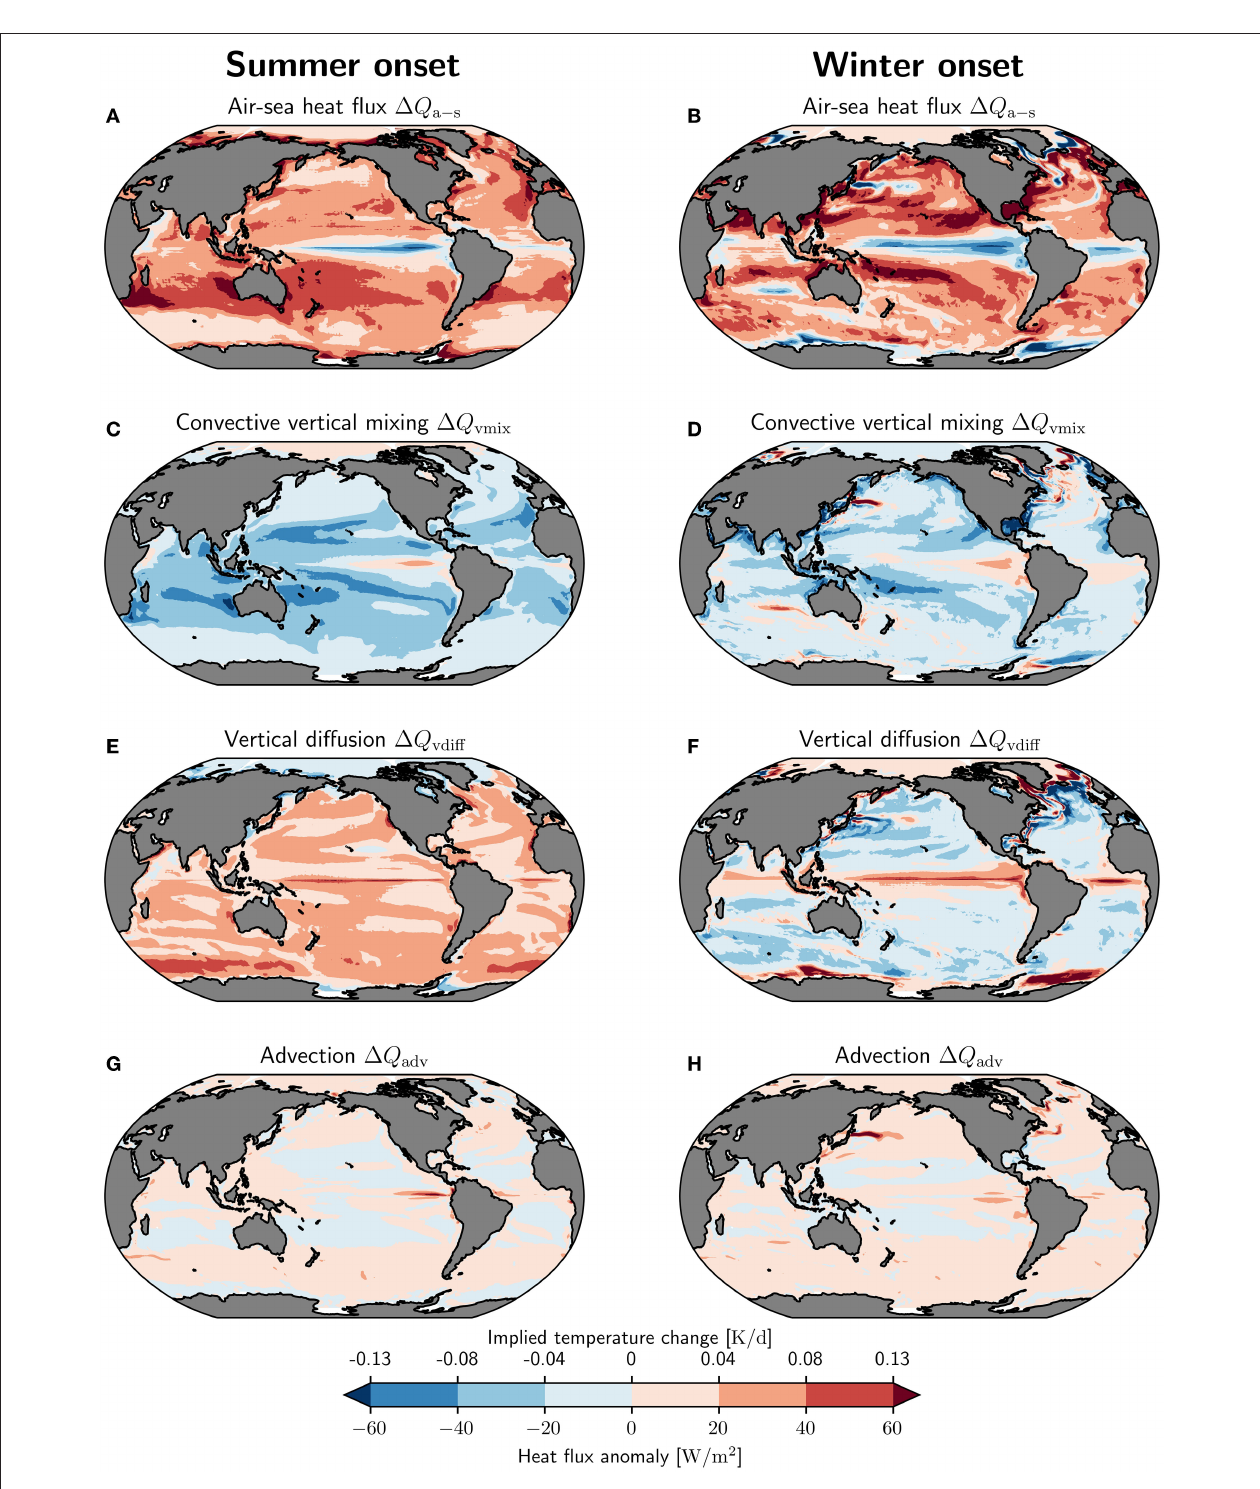
FIGURE 5 | Seasonal decomposition of marine heatwave driver anomaly patterns during the onset phase. Heat flux anomalies for the four most important marine heatwave drivers averaged over marine heatwave onset days during summer (A,C,E,G) and winter (B,D,F,H) . The summer and winter maps show the anomalies averaged over the respective season in both hemispheres simultaneously, i.e., for summer (winter), the maps use JJA (DJF) for the Northern Hemisphere and DJF (JJA) for the Southern Hemisphere. The climatological mean state for these terms during summer and winter is given in Supplementary Figure 3 .